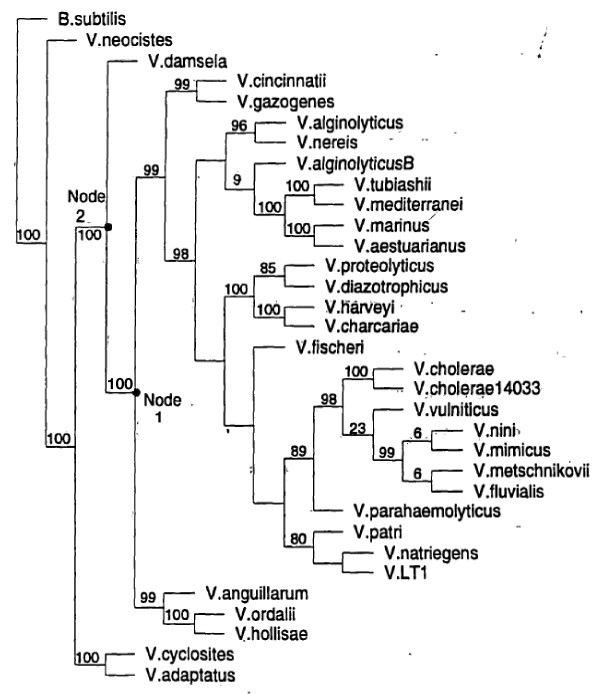
Representative phylogenetic tree from the 100 tree set. Nodes labeled 1 and 2 are the two ancestral nodes which were constructed and evaluated experimentally for validity as 5S rRNAs. Numbers above the branches indicate the frequency with which that branch was found in the 100 tree set.